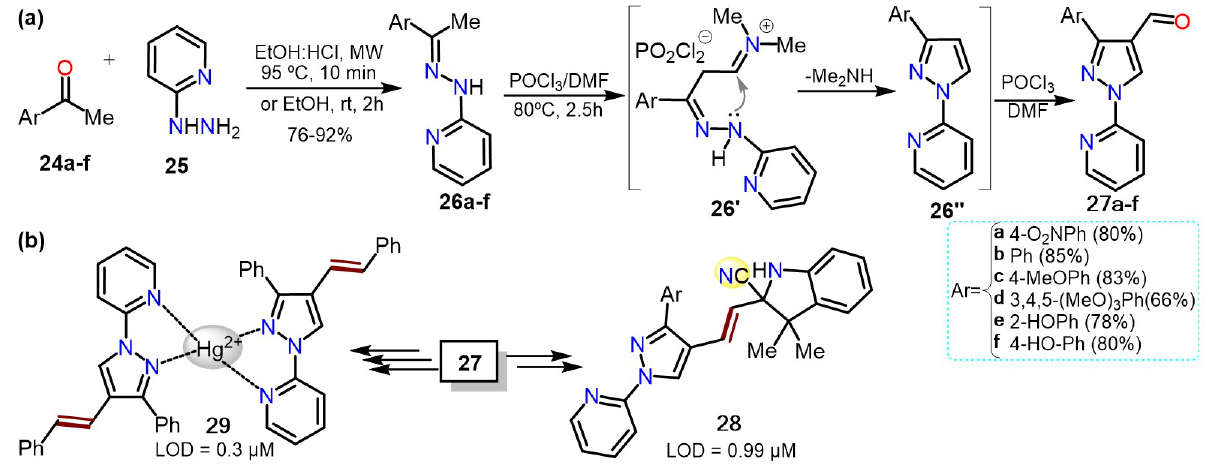
Scheme 6. Synthesis of ( a ) 4-formyl-1-(2-pyridyl)pyrazoles and ( b )chemosensors based on